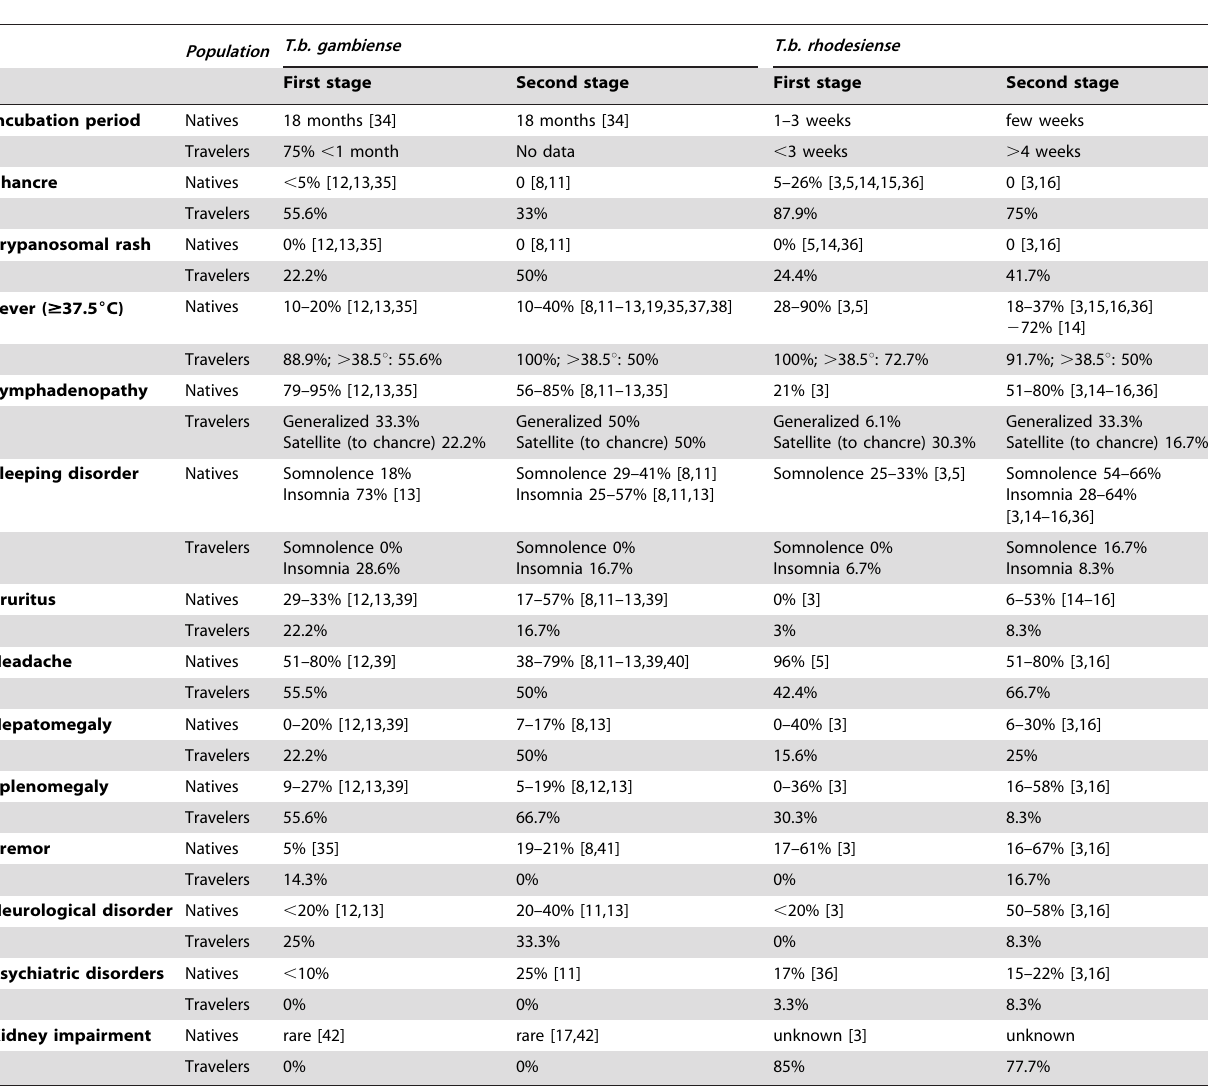
Table 7. Signs and symptoms according to stage and affected